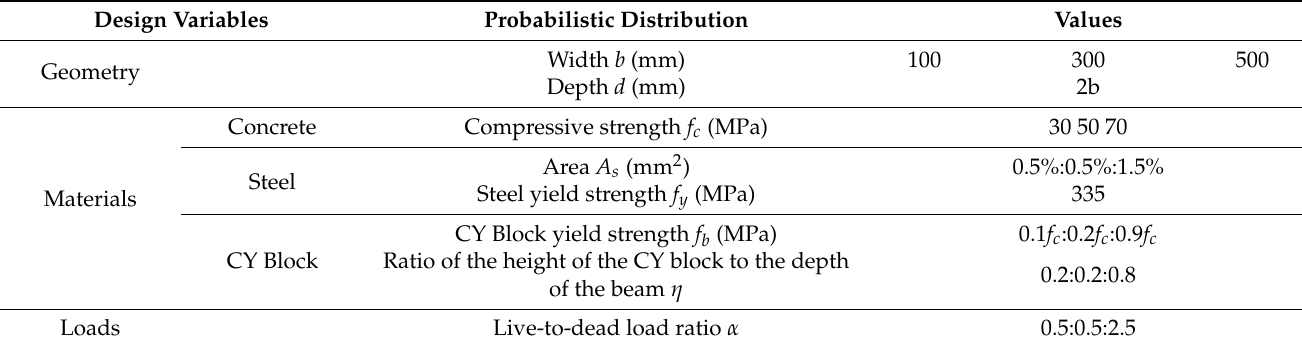
Table 4. Summary of design